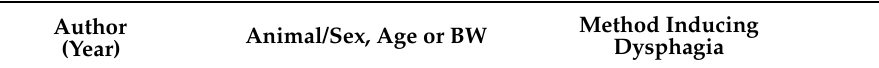
Table 3. Characterization of oropharyngeal dysphagia in rodent models of amyotrophic lateral